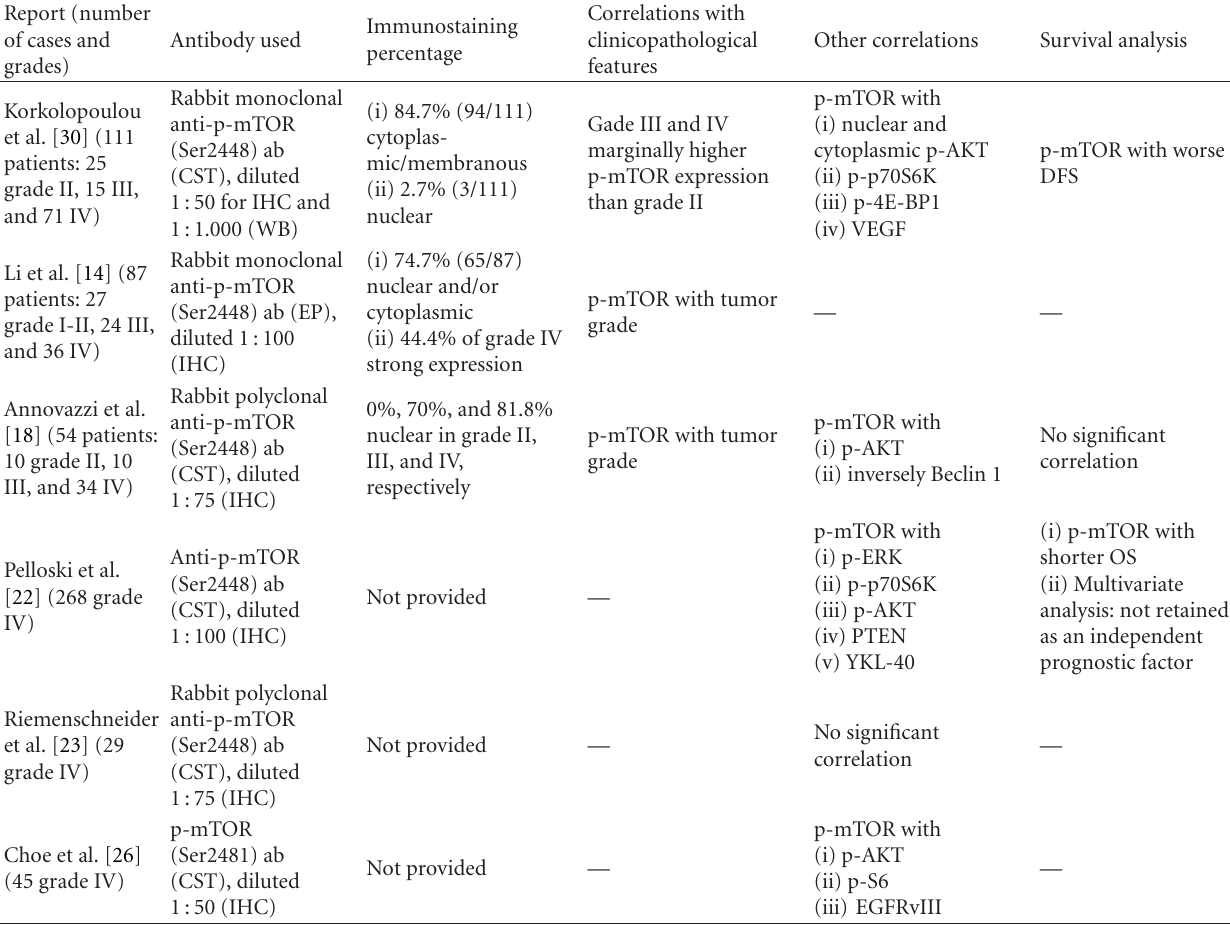
Table 2: Summary of reports investigating the role of mTOR activation in